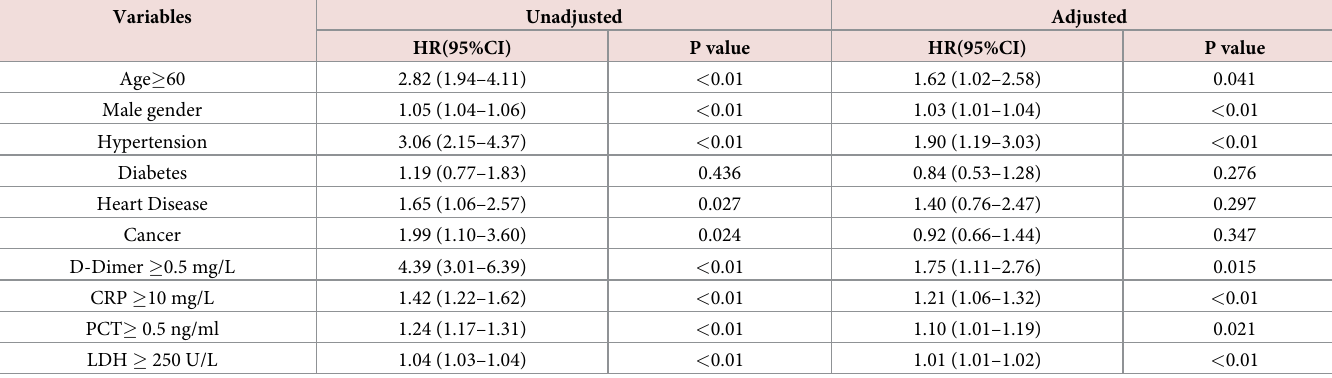
Table 3. Univariate and multivariate Cox proportional hazard analysis of risk variables for hospital mortality.